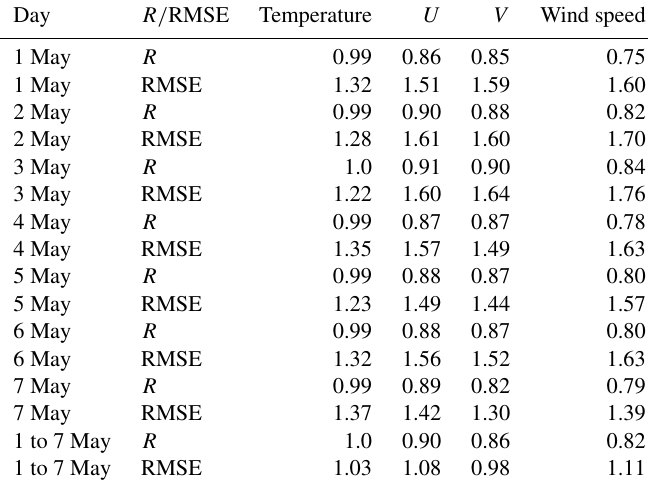
Table 4. Correlation coefficient ( R ) and root mean square error (RMSE) between WRF-Chem simulation and FNL reanalysis data for daily mean temperature at 2m, U component of wind, V component of wind, and wind speed at 10m during the dust event time period over the whole domain. The last two rows show the R and RMSE for the time-averaged temperature at 2m, U component of wind, V component of wind, and wind speed at 10m from 1 to 7 May. Day R/ RMSE Temperature U V Wind